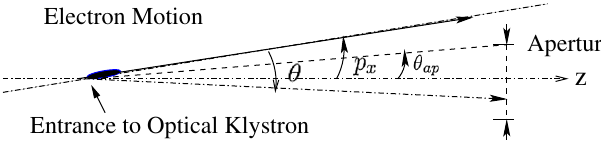
FIG. 6. Illustration of the electron trajectory and emission in an optical klystron with planar undulators. The electron is moving in the midplane of the undulator field with a horizontal (the normalized horizontal momentum) with respect to angle p x the longitudinal z axis. The radiation is collected behind an . The radiation is collected aperture opening with half-angle (cid:8) ap at a particular opening angle (cid:8) with respect to the electron